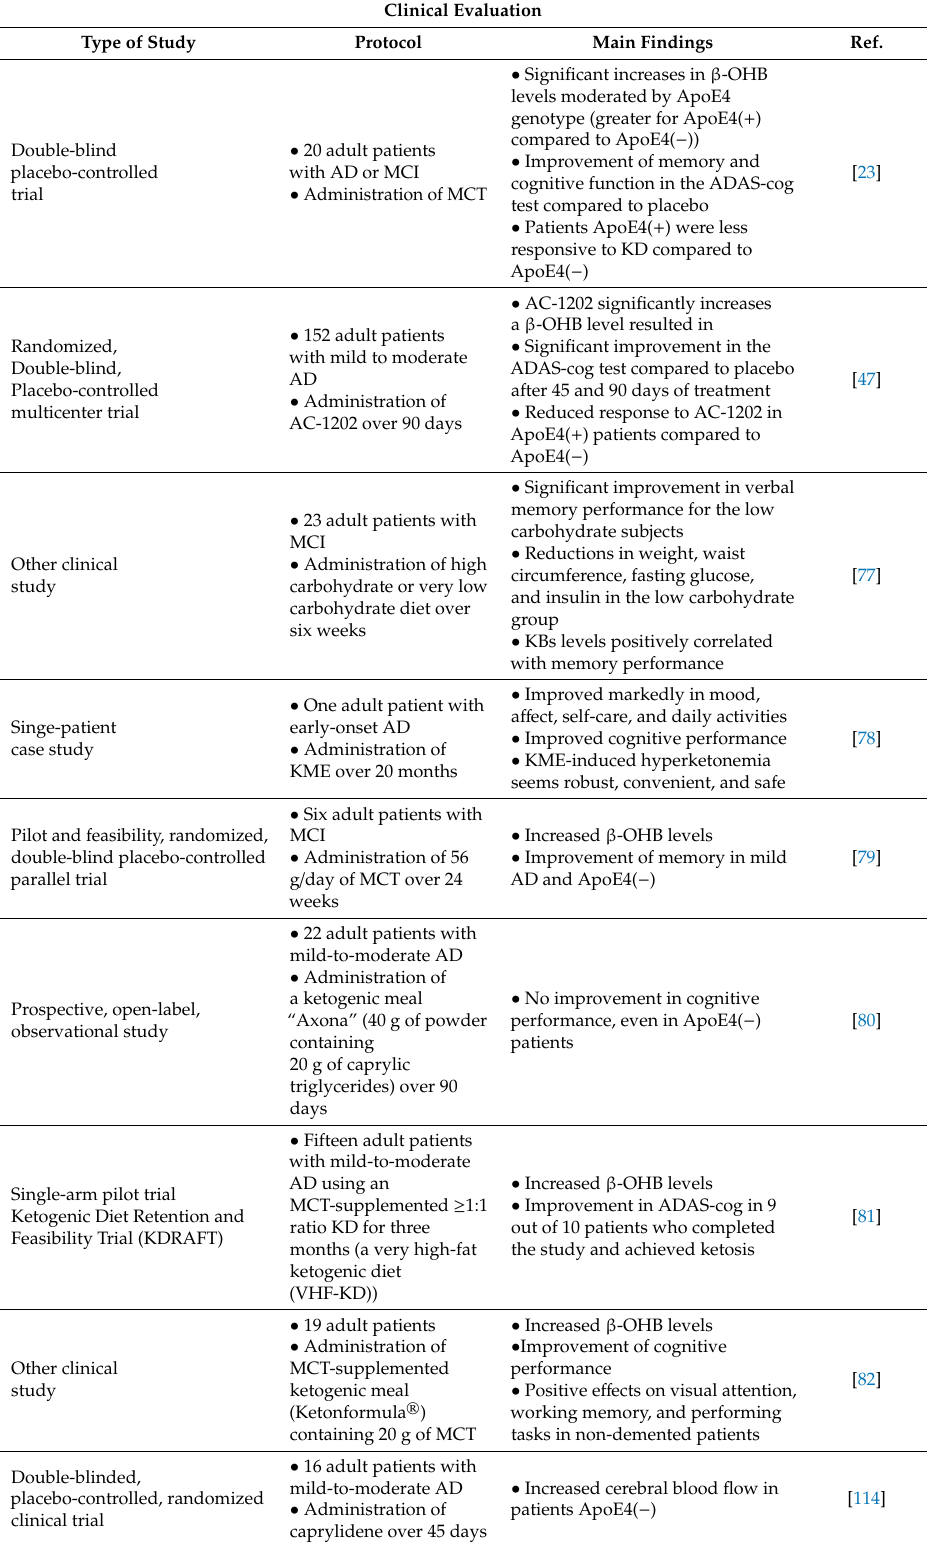
Table 2. Main clinical evaluations of KD treatment in